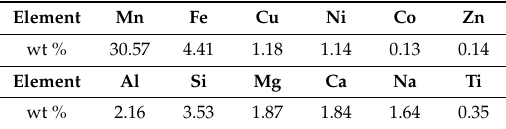
Table 1. Content of main metals in nodules.